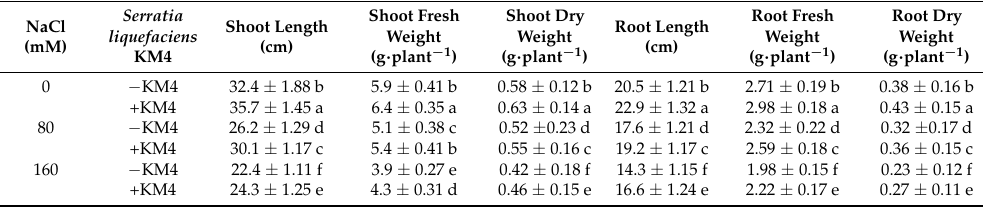
Table 1. Maize growth and biomass production in the presence or absence of Serratia liquefaciens KM4 under salt stress.